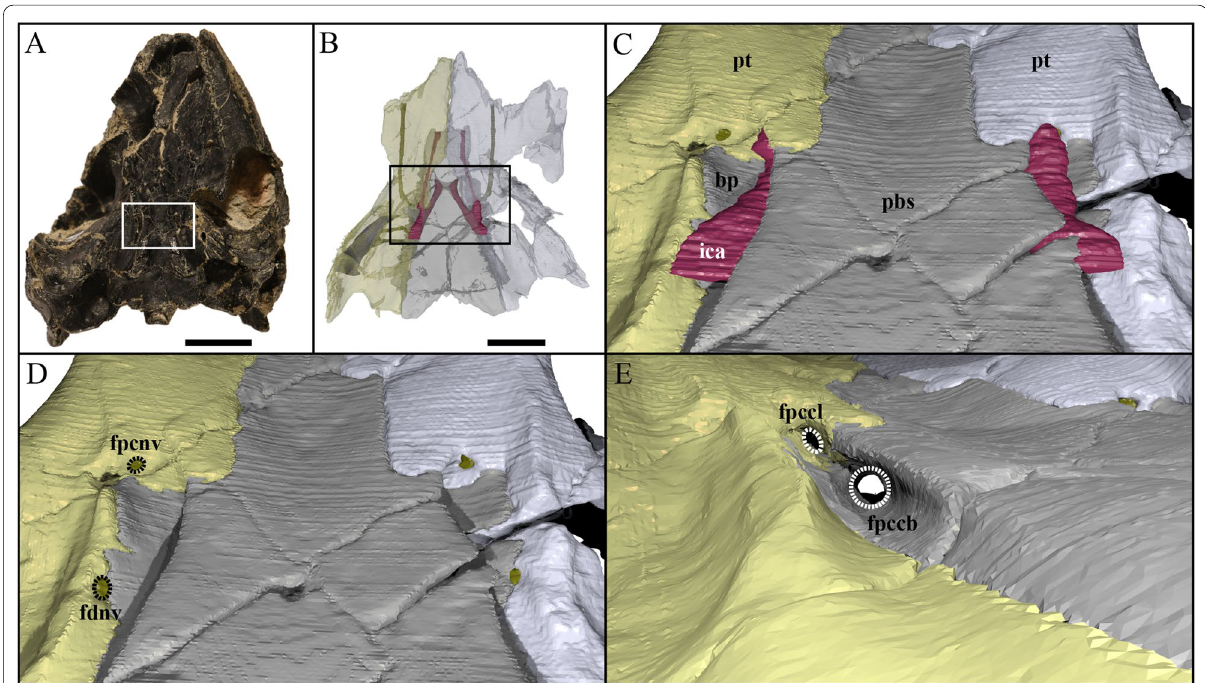
Fig. 6 Close-ups on the basicranium and carotid pit of UCM 53971. A Indication of the location of the area of interest in the skull, B indication of the location of the area of interest relative to Fig. 5, C close-up on the basicranium highlighting the path of the internal carotid artery, D close-up on the basicranium highlighting foramina for the vidian nerve, and E close-up on the right carotid pit highlighting foramina for the carotid circulation system. bp basipterygoid process, fdnv foramen distalis nervi vidiani, fpccb foramen posterius canalis carotici basisphenoidalis, fpccl foramen posterius canalis carotici lateralis, fpcnv foramen posterius canalis nervi vidiani, ica internal carotid artery, pbs parabasisphenoid, pt